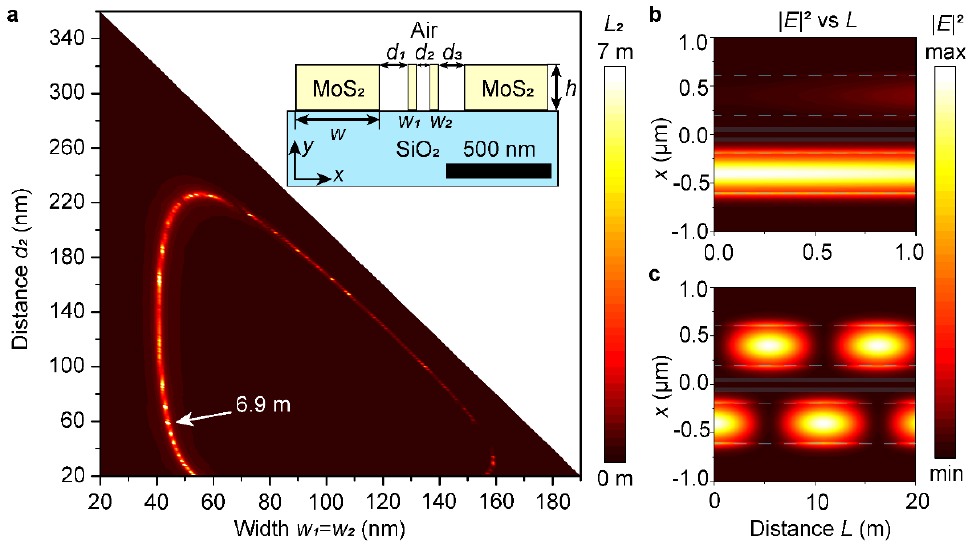
Figure 3. Two-stripes structure. ( a ) Dependence of the crosstalk distance L 2 on the separation between stripes d 2 and their width w 1 = w 2 . White arrow points at the point with the largest crosstalk distance. The inset shows a schematic view of the optimized structure. ( b ) The electric field intensity distribution versus y and L with a propagation length of 1 m and ( c ) 20 m. The plots are linear scale. The dashed lines in panels ( b ) and ( c ) show the waveguide edges. Table 1. Comparison of the crosstalk distance enhancements with other works.